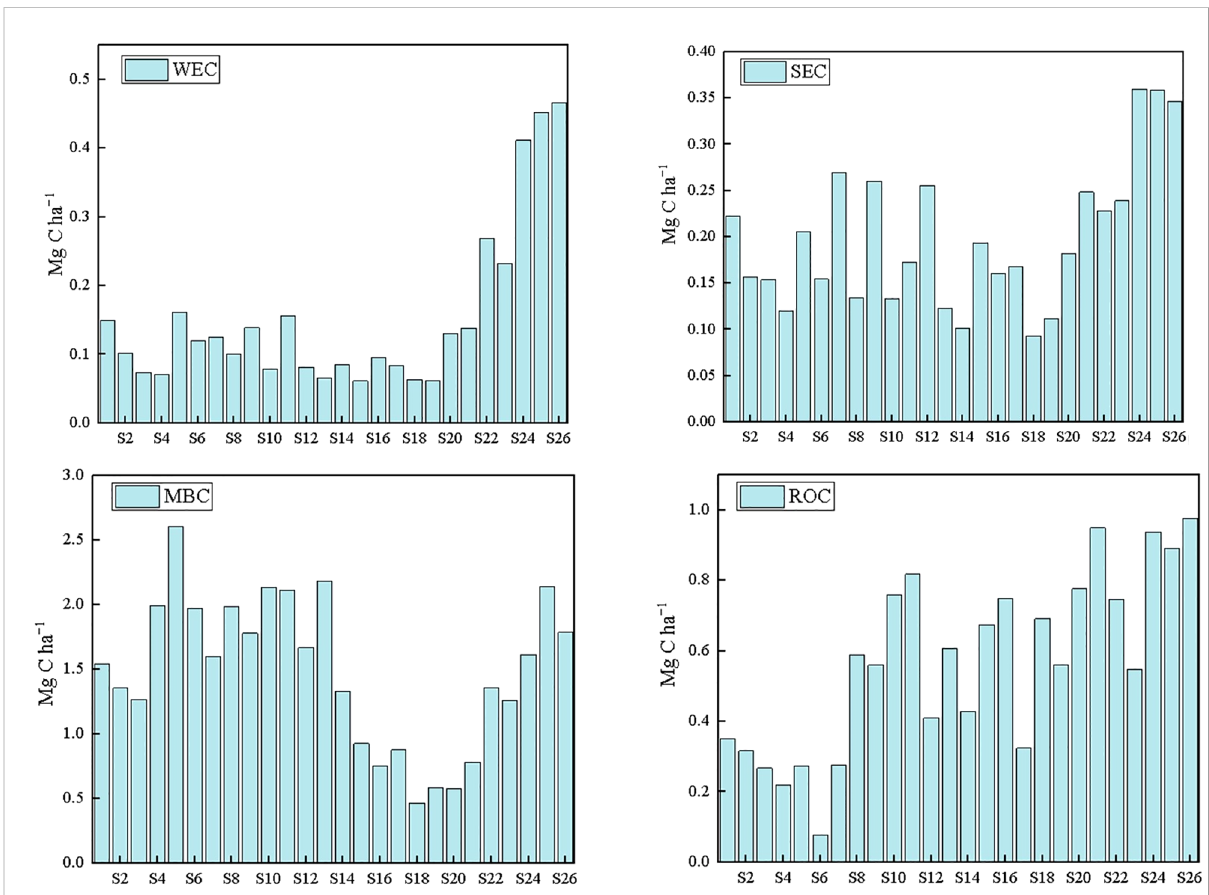
FIGURE 8 The stock of WEC, SEC, MBC and ROC of the surface sediment in this work (note: even-numbered sites are